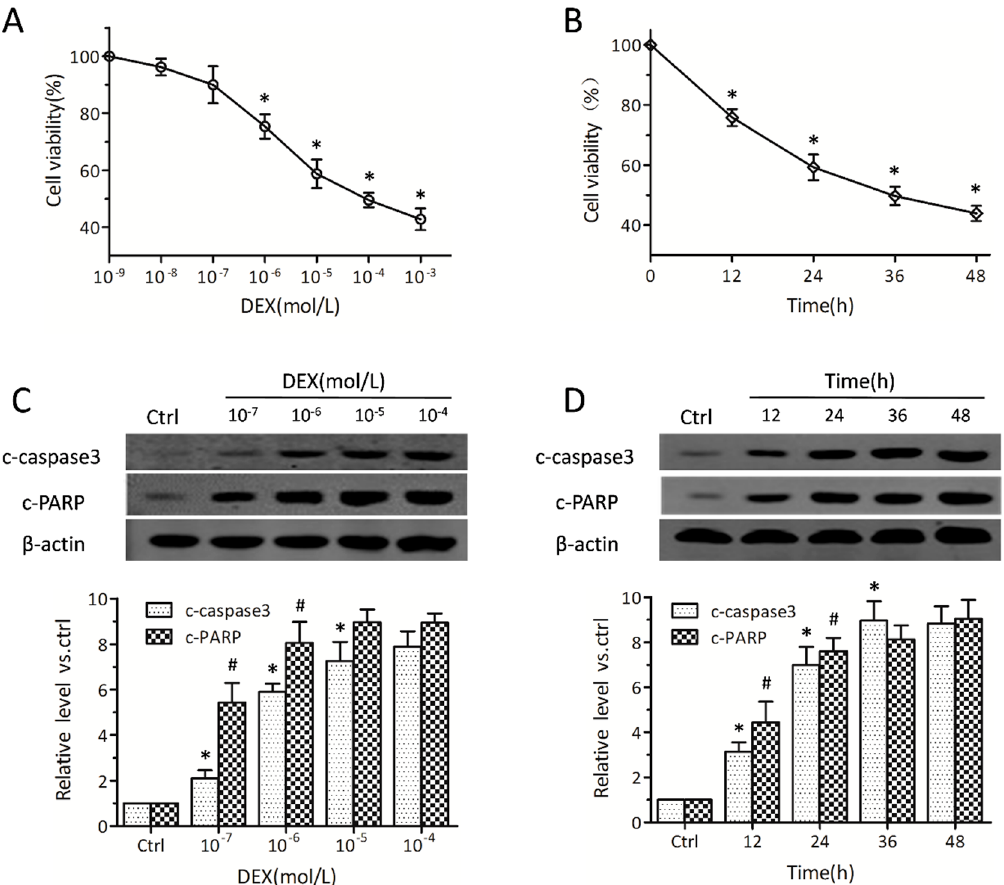
Figure 1. Dexamethasone (DEX) induces cell death and promotes apoptosis in MC3T3-E1 pre-osteoblasts. MC3T3-E1 pre-osteoblasts were exposed to DEX at different concentrations (10 − 9 , 10 − 8 , ···, 10 − 3 mol/L) for 24 h; in addition, cells were incubated with 10 − 5 mol/L DEX for different times (0, 12, 24, 36, and 48 h). ( A , B ) Cell viabilities were detected by CCK-8 (cell counting kit-8) ( n = 4, * p < 0.05 vs. the two adjacent groups); ( C , D ) Cleaved caspase-3 and poly(ADP-ribose) polymerase (PARP) amounts were assessed by Western blot ( n = 4, * p and # p < 0.05 vs. the two adjacent groups). Data were expressed in fold induction, relative to baseline or control values. Data are mean ± SD.